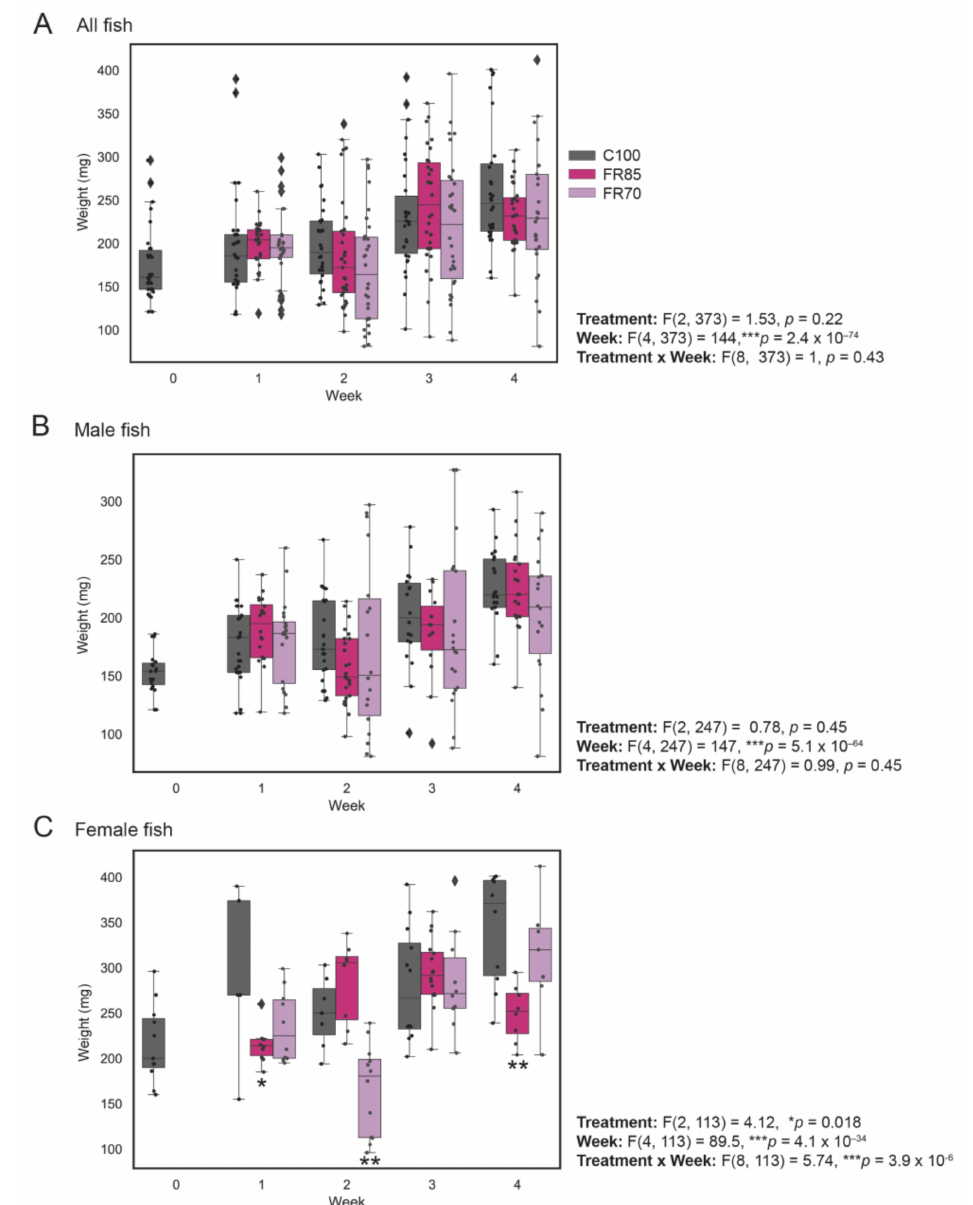
Figure 2. Weight profiles of zebrafish fed to visual satiety compared to feed-restricted fish (85% and 70% feeding). Feed restriction (85% and 70% feeding) was performed at 3 mpf and the weight measurements were recorded on a weekly basis for a period of 4 weeks. The combined weight of males and females (all fish), only males and only females are shown in ( A – C ), respectively. The box plot shows median, interquartile interval, and data range excluding outliers; each dot represents an individual fish. (cid:7) represents an outlier. Two-way ANOVA was used to infer the significant effects of treatment, week, or treatment by week interactions, followed by Tukey’s multiple comparison test to identify significantly different means. Means that are significantly different from Group 100% are noted with—* Padj < 0.05, ** Padj <